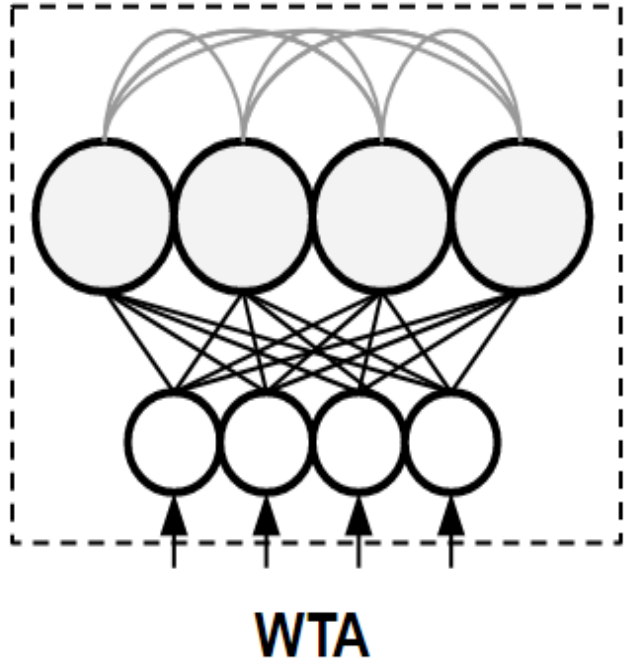
Figure 1. A WTA architecture that can be used in the proposed TinyML chip. The black lines indicate the synaptic connections between the input and output layers. The gray lines show the inhibitory connections of the output